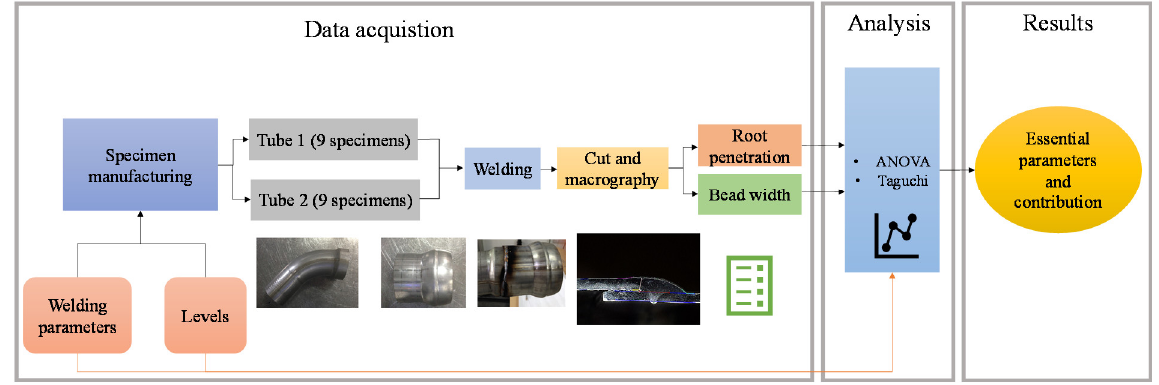
Figure 1. Flowchart of the experimental work followed for this research. The specimens were manufactured specifically for this research using welding. The